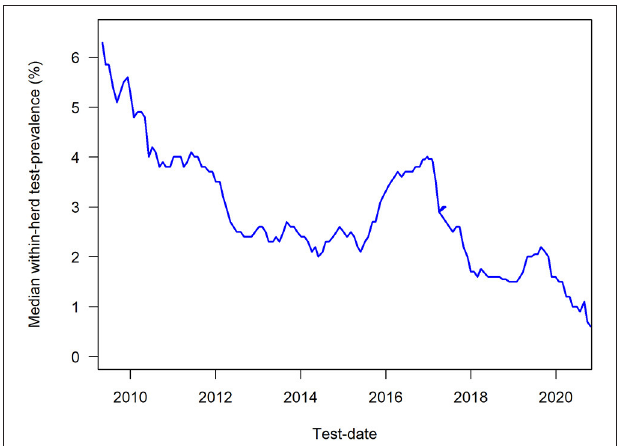
FIGURE 3 | Map of the distribution of S . Dublin surveillance levels on properties with cattle in Denmark on the 24th of March 2021. Green marks: S . Dublin Level 1, Red rings: Level 2 or 3 (test-positive and other properties not in Level 1). (Source: SEGES, Aarhus, Denmark).